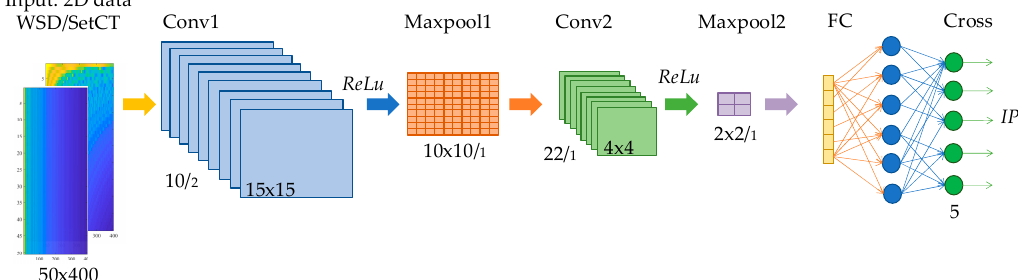
Figure 10. Convolutional neural network (CNN) structure for full-resolution 2D data.